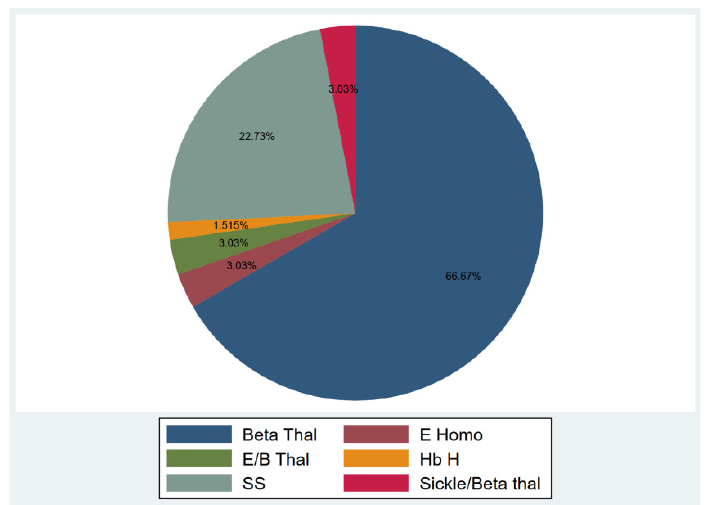
Figure 1. Hemoglobinopathies distribution.